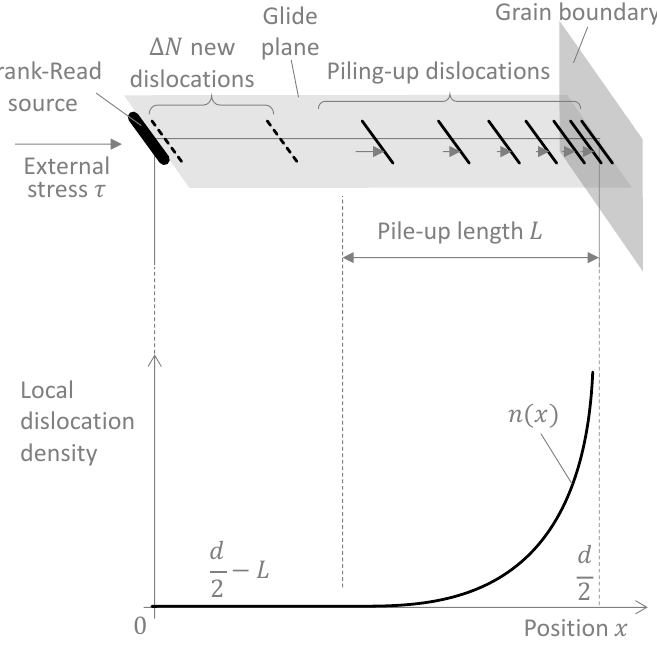
Figure 4. Schematic representation of dislocation pile-up at a grain